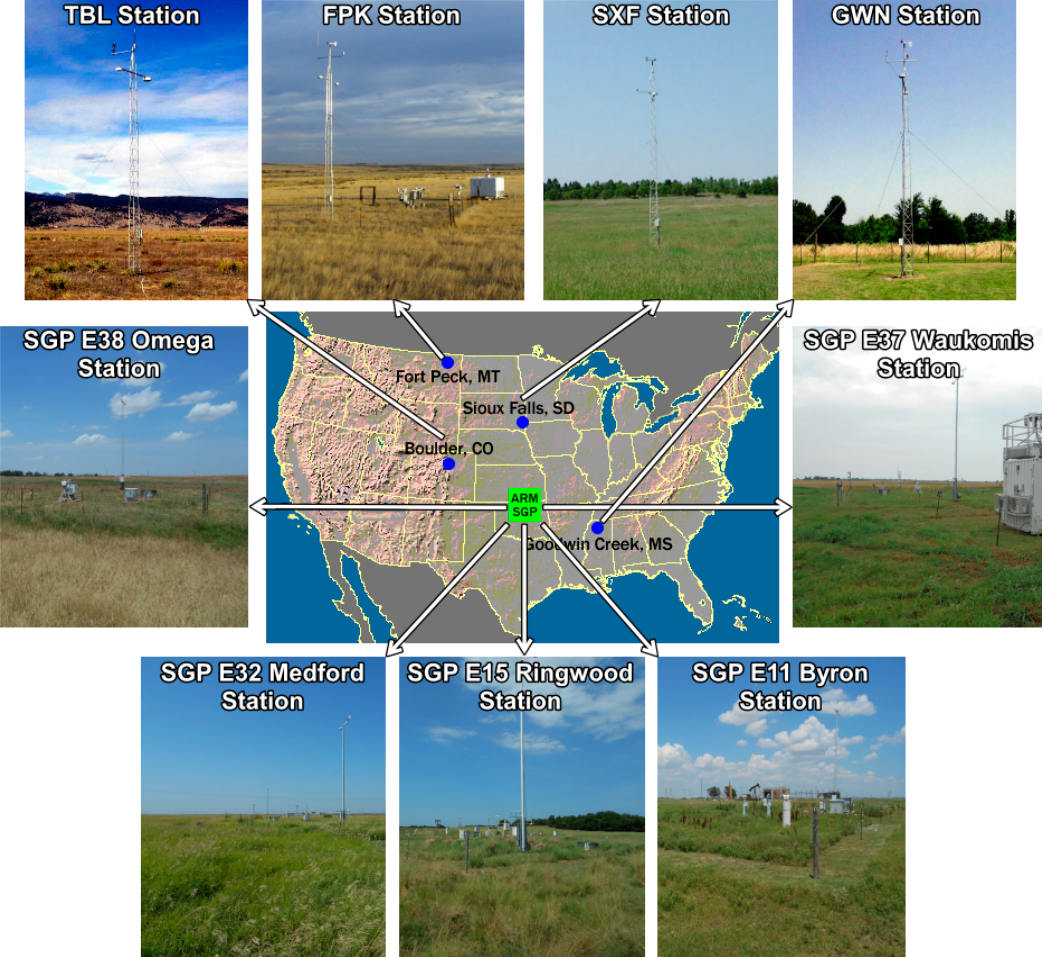
Figure 1. Illustration of the locations and surface covers of the Surface Radiation Budget Network (SURFRAD) and Atmospheric Radiation Measurement (ARM) stations used in this study.